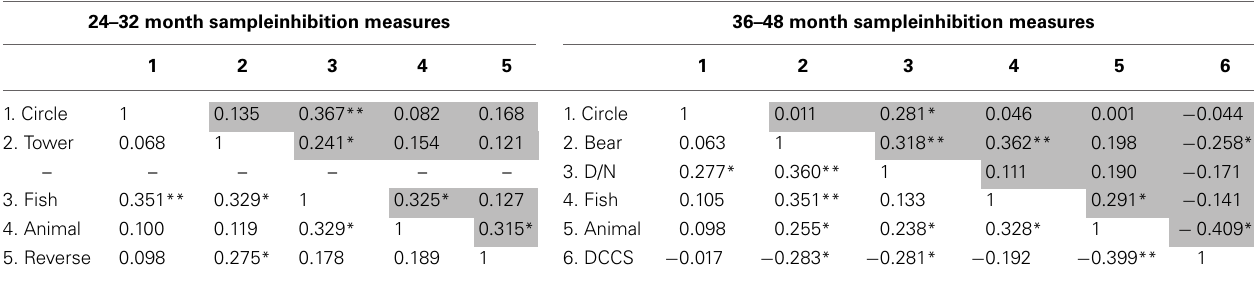
Table 2 | Zero order and partial correlation controlled for age (upper triangle) between inhibitory measures in 24–32 month sample and in 36–48 month